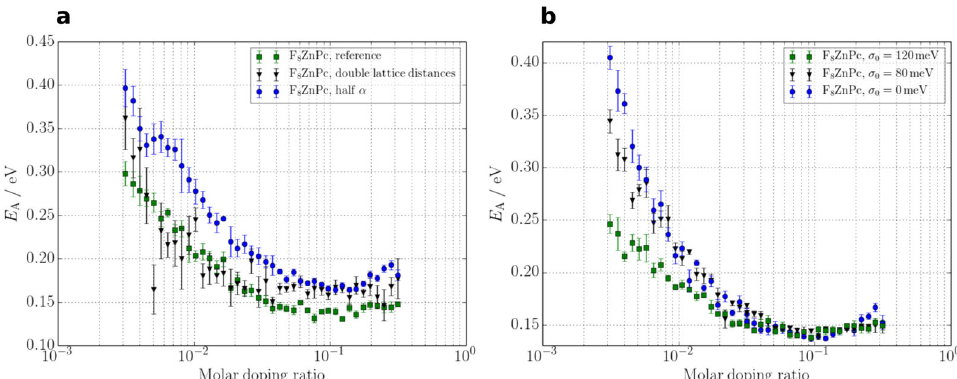
Fig. 5 In fl uence of spatial parameters and intrinsic disorder on the calculated activation energy of conductivity for F 8 ZnPc. a This plot underlines that the spatial and energetic aspects of transport are closely connected: Halving the localization radius α (blue circles) compared to a reference sample (green squares), i.e. doubling the penalty of long-distance hops, also increases the activation energy by up to 100 meV. This is not obvious, since the exponent of the hopping rate (Eq. (6)) that contains α does not even depend on temperature. The connection of α and E A only emerges due to the tradeoff of variable- range hopping: For stronger localization, low-energy hops are more likely to be traded for short-distance hops. Since the typical critical hopping distance is the distance between dopants at low doping ratios, lowering the dopant distance is the main reason for the decrease in activation energy upon increasing doping ratio. Interestingly, decreasing α is not equivalent to increasing the lattice distances d (black triangles) at low and moderate doping ratios. At high concentrations, however, where the charges get very close and the typical hopping distance saturates at the lattice distance, the effect of halving α and of doubling d becomes equivalent. b E A versus molar doping ratio for F 8 ZnPc with different widths σ 0 of the intrinsic energetic disorder. Remarkably, the sample with the highest intrinsic disorder exhibits the lowest E A at low doping concentrations. The reason are matrix sites that are randomly lowered in energy by the intrinsic disorder and can serve as bridging sites between the dopant wells (see Fig. 3). This bene fi t disappears at high doping concentrations, where the notion of individual dopant wells vanishes. Error bars show one standard